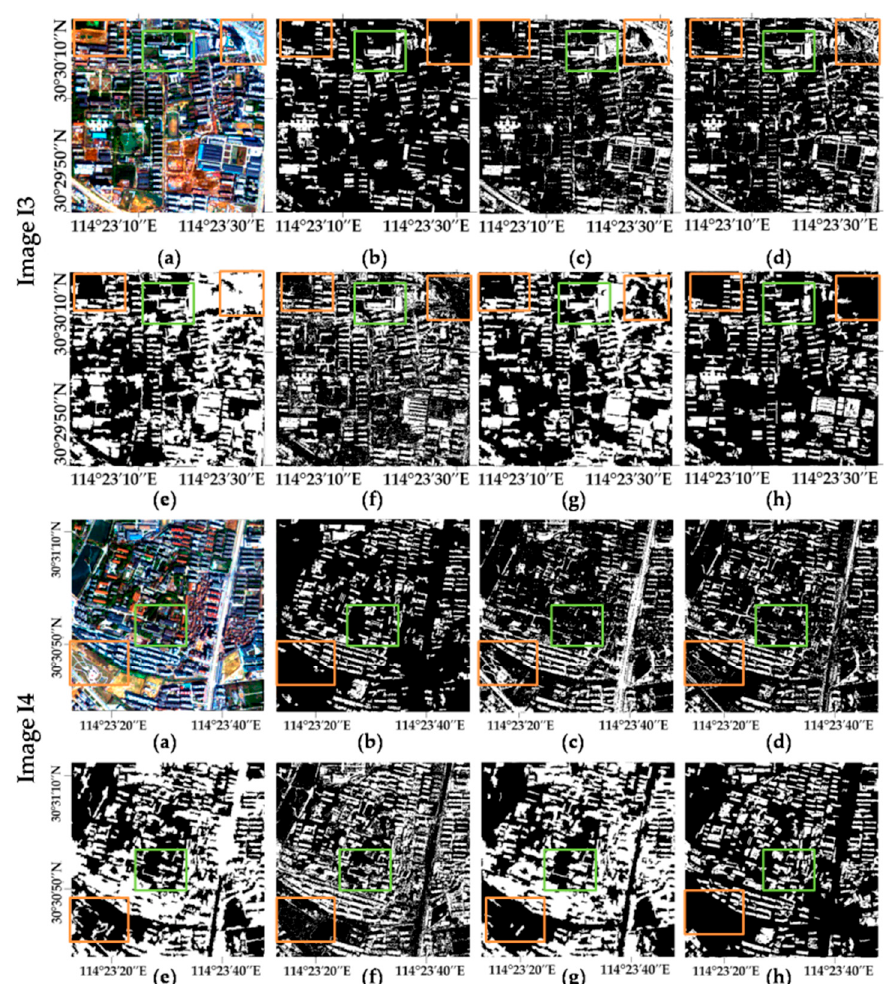
Figure 10. Building detection results of Test Patches I3 and I4. ( a ) RGB image; ( b ) MBI results; ( c – e ) the building maps with the results of the pixel-based SVM, DMP-SVM, and object-oriented SVM, respectively; ( f , g ) DMP-RF and object-oriented RF results; ( h ) the proposed method results.